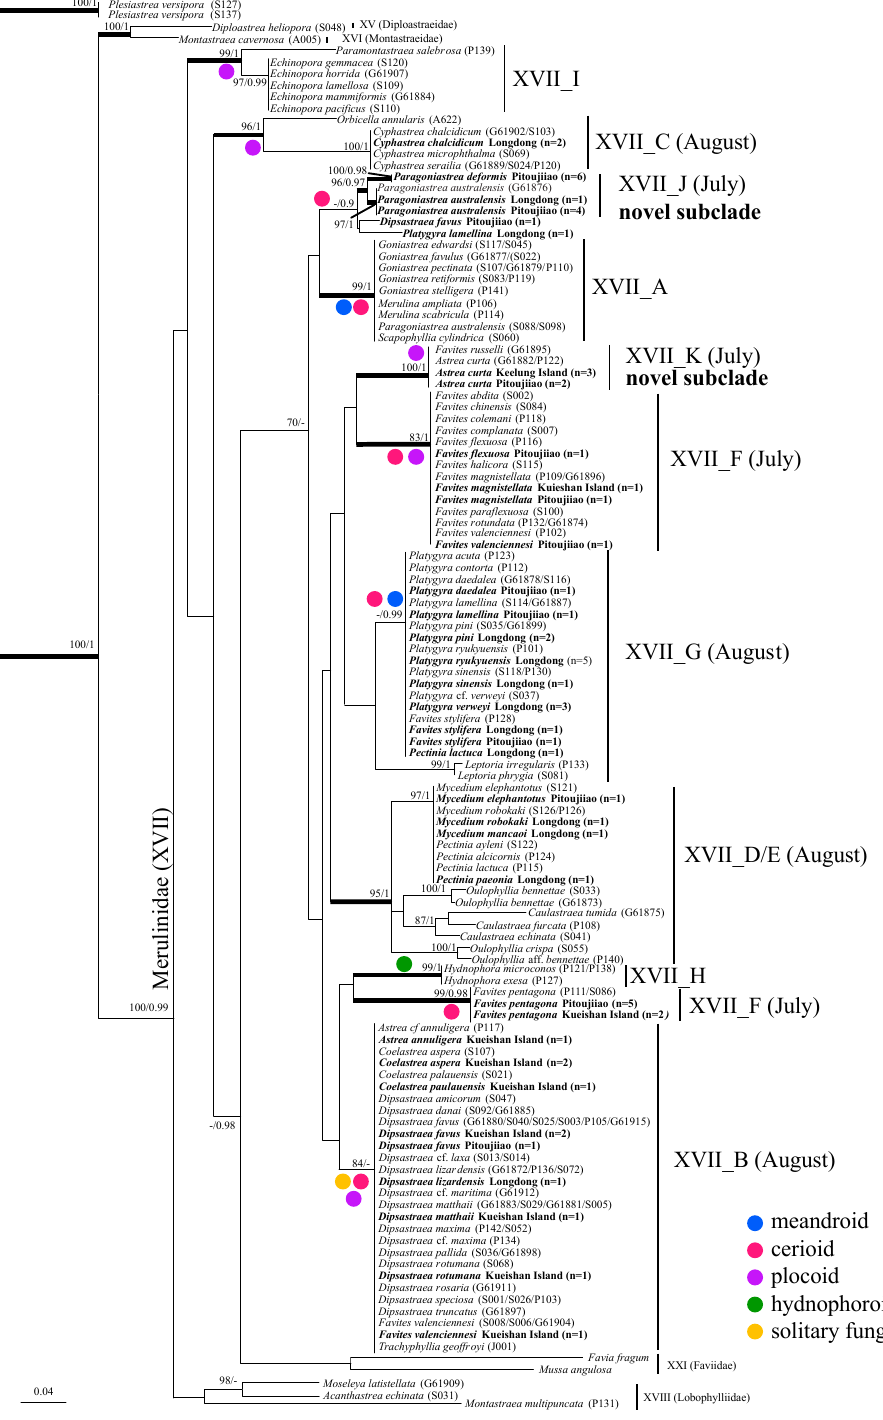
Figure 2. Phylogenetic tree of merulinid corals and their allies based on the combined gene dataset inferred with the maximum likelihood method using the GTR+G model. Molecular subclades within Merulinidae (XVII) are defined as being A to I following Huang et al. [10]. The other two novel clades (J and K) are defined in this study. Branch lengths are proportional to inferred nucleotide substitutions. Numbers at the nodes represent bootstrap values (only ≥ 70 shown) from the maximum likelihood method and posterior probability (only ≥ 0.9 shown) from the Bayesian inference. Bold branches on the tree indicate statistically robust nodes. The spawning month of specimens in Chen et al. [32] are in